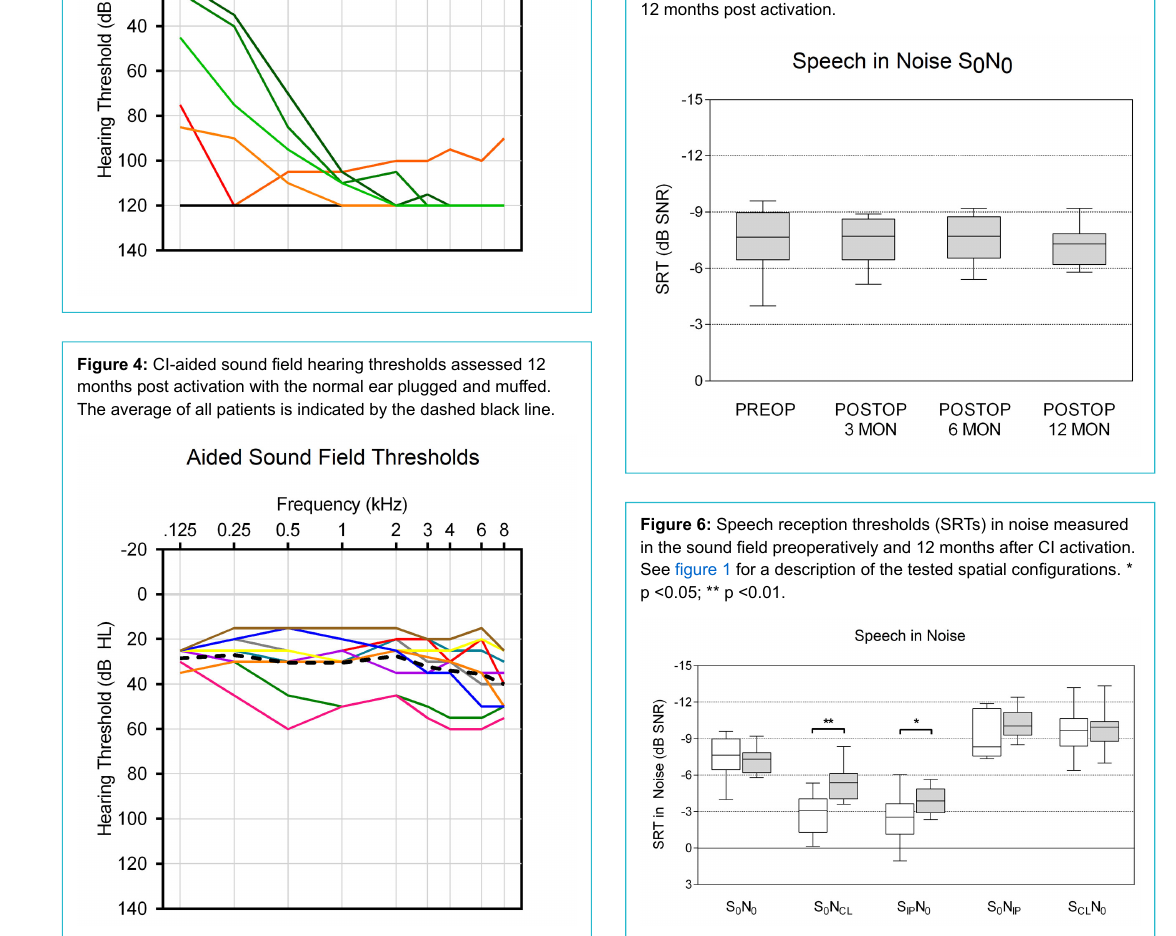
Figure 5: Speech reception threshold (SRT) in noise measured in the sound field (S 0 N 0 ) assessed preoperatively as well as 3, 6, and 12 months post activation.